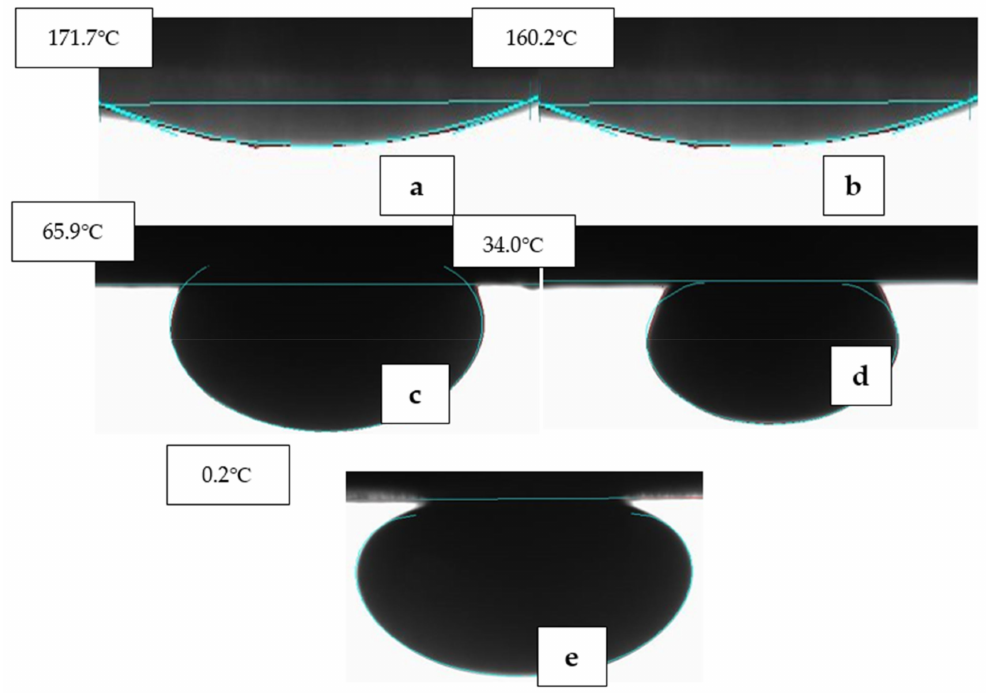
Figure 18. Effect of EW-NF on pellet treatment at elevated temperature: ( a ) The initial oil-wet state; ( b ) after soaking in 4dsw2Mg2S for 24 h; ( c ) after soaking in 4dsw2Mg2S-NP for 24 h; ( d ) after soaking in 4dsw2Mg2S-NP for a further 24 h; ( e ) after soaking in 4dsw2Mg2S-NP for a further 48